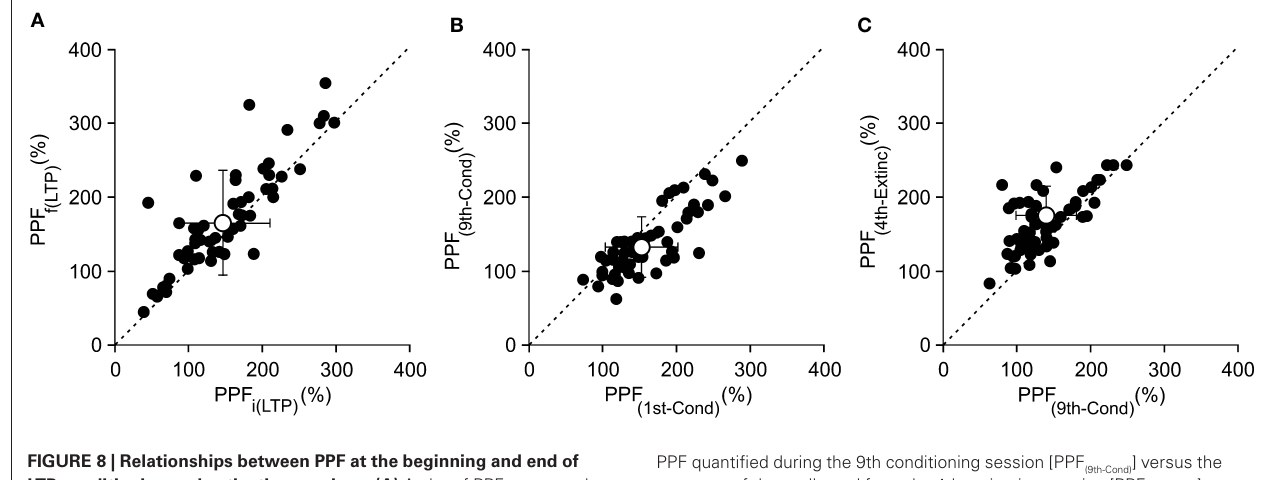
FIGURE 8 | Relationships between PPF at the beginning and end of LTP, conditioning and extinction sessions. (A) A plot of PPF, computed 15 min after the HFS session [PPF ], against PPF, computed 24 h i(LTP) following HFS trains [PPF ]. Note that most PPF values were larger f(LTP) f(LTP) than those collected for PPF . (B) A similar plot relating PPF computed i(LTP) during the 1st conditioning session [PPF ] against that during the (1st-Cond) 9th